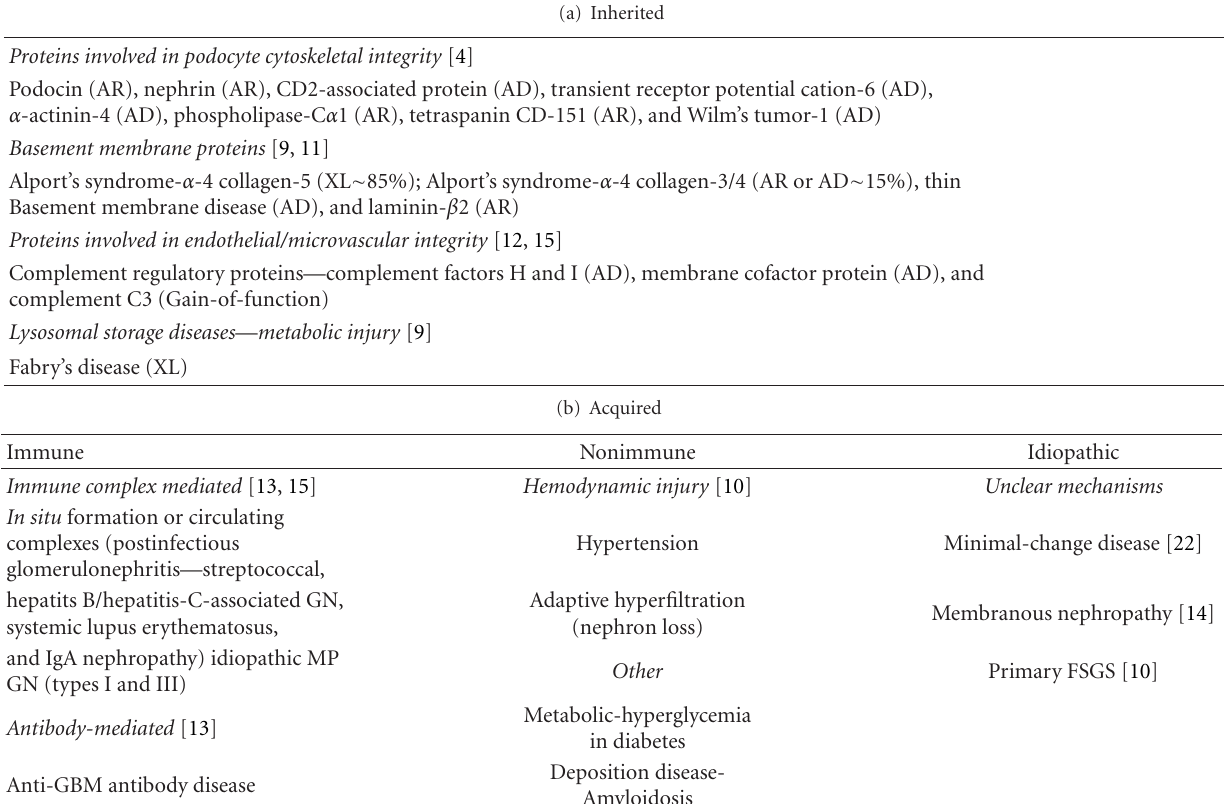
Table 1: Classification of glomerular injury by